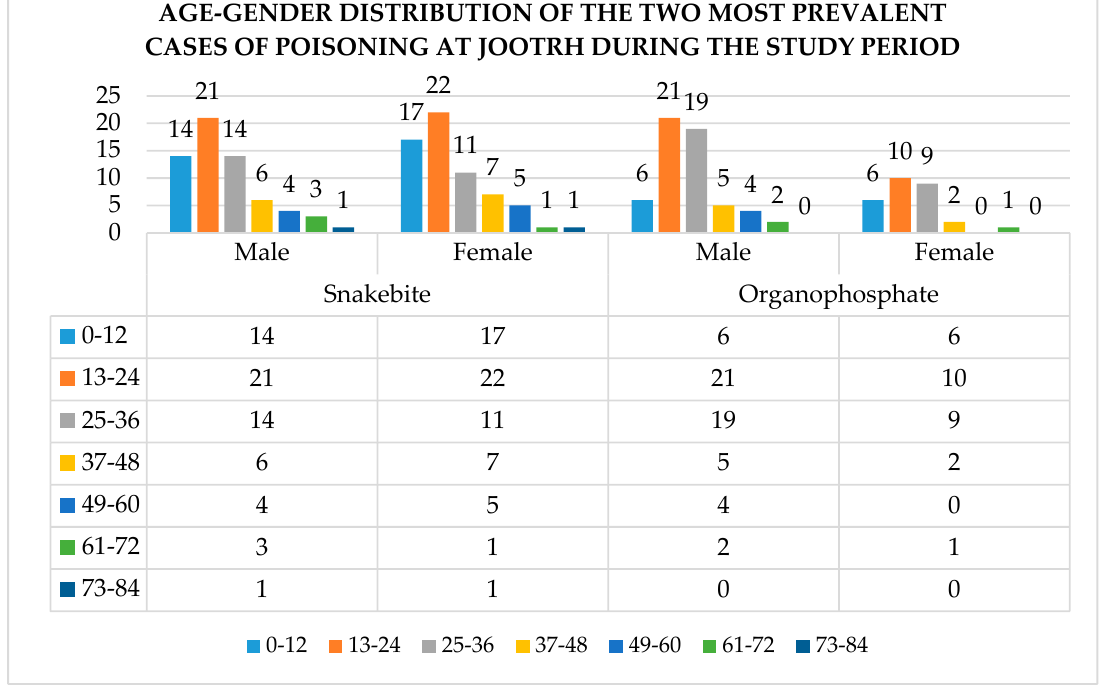
Figure 2. Distribution of the two most common causes of poisoning in the study area.